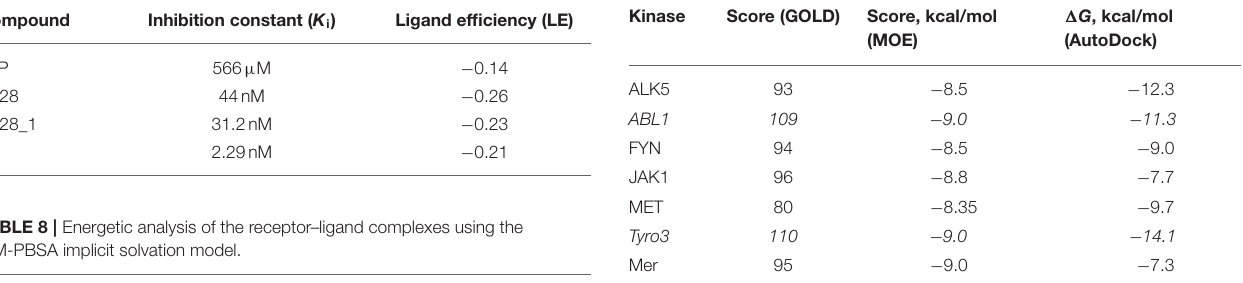
TABLE 11 | The docking scores for the compound R5 against ALK5, ABL1, FYN, JAK1, MET, Tyro3, and Mer according to the GOLD, MOE, and AutoDock software.